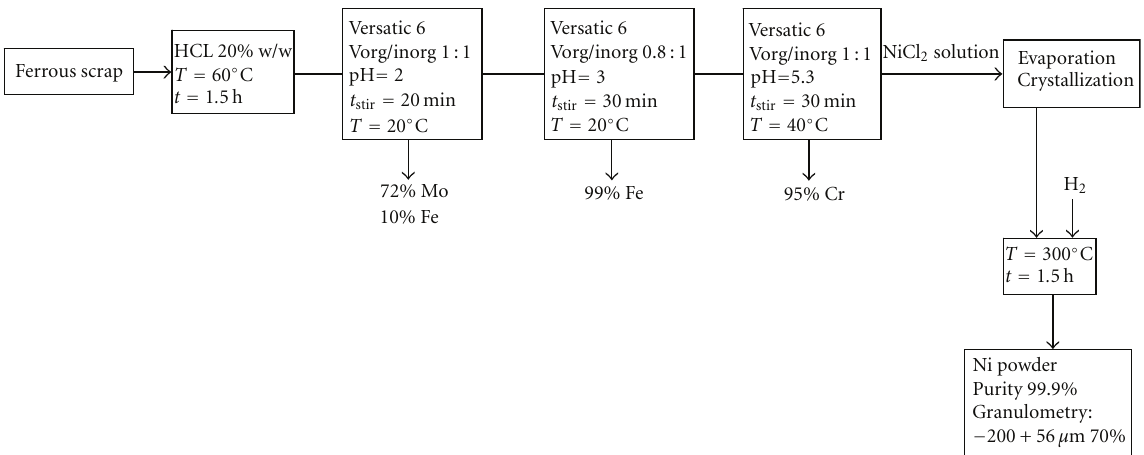
Figure 1: Flowsheet of the hydrometallurgical method for nickel recovery in powder form, showing the process optimal conditions.